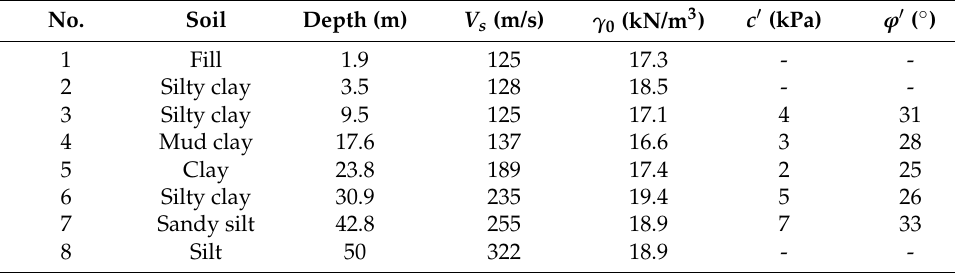
Figure 1. Prototype. ( a ) Location of the prototype station in the metro route map of Shanghai, China. ( b ) 3D model of the prototype station with the key dimensions (unit: m). Table 1. Prototype soil profile and key soil properties of the encountered